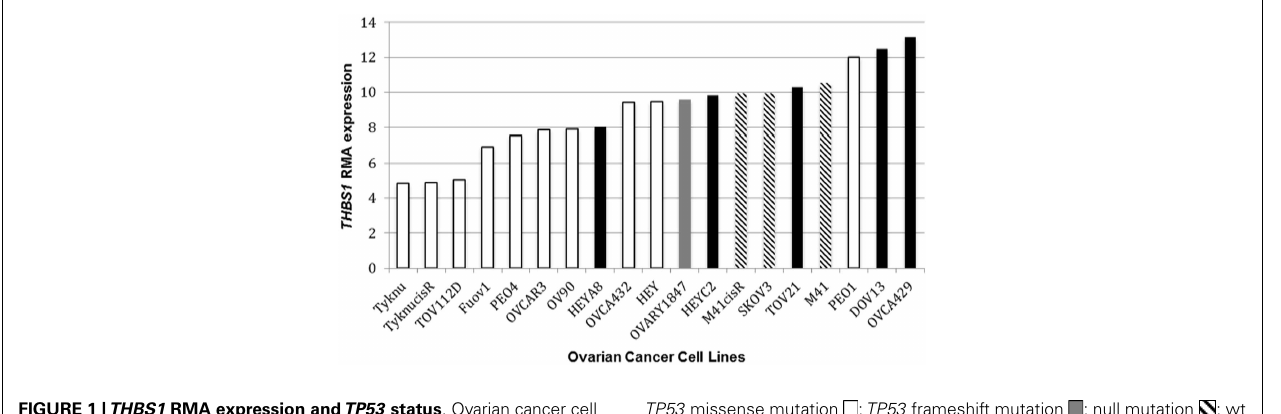
FIGURE 1 | THBS1 RMA expression and TP53 status . Ovarian cancer cell lines harboring a TP53 missense mutation bars had lower THBS1 RMA expression compared to cell lines with an intact wild-type (wt) TP53 gene. RMA-normalized values from the Affymetrix U133A gene chip.